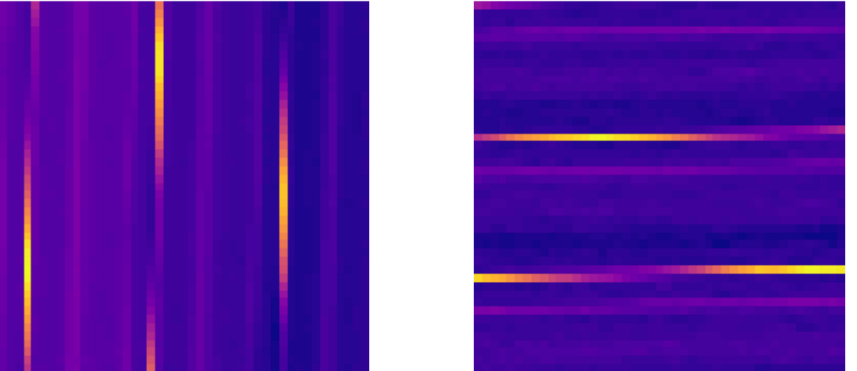
Figure 10. ( Left ) A ground truth example for the transposed model. ( Right ) A ground truth example for the reversed model.